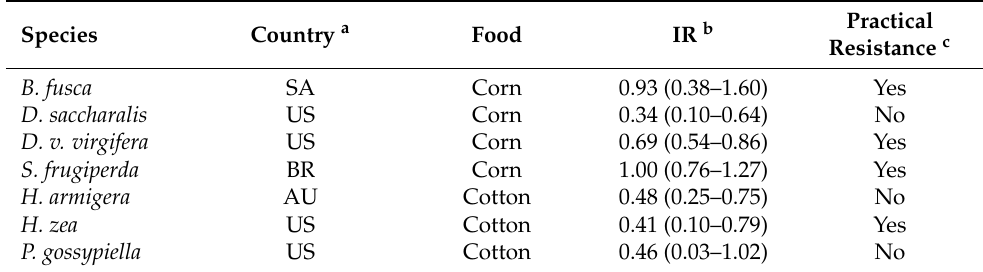
Table 3. Incomplete resistance (IR) for species from different countries fed Bt and non-Bt corn or Bt and non-Bt cotton.